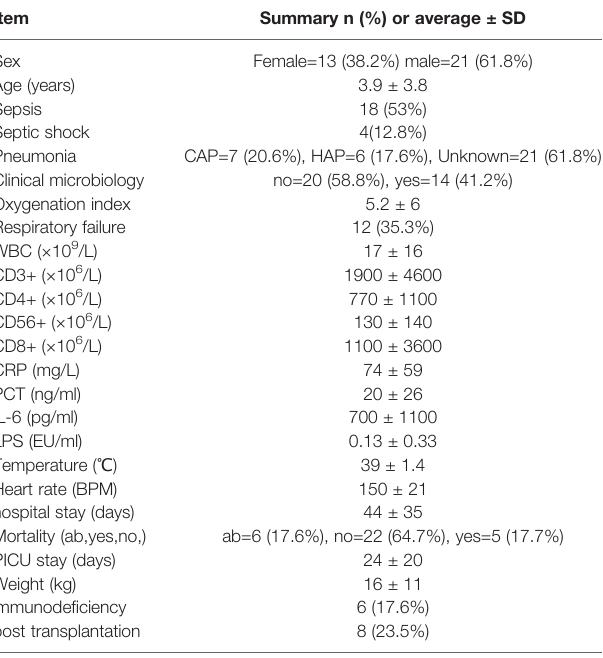
TABLE 1 | Statistics of patients ’ clinical information.